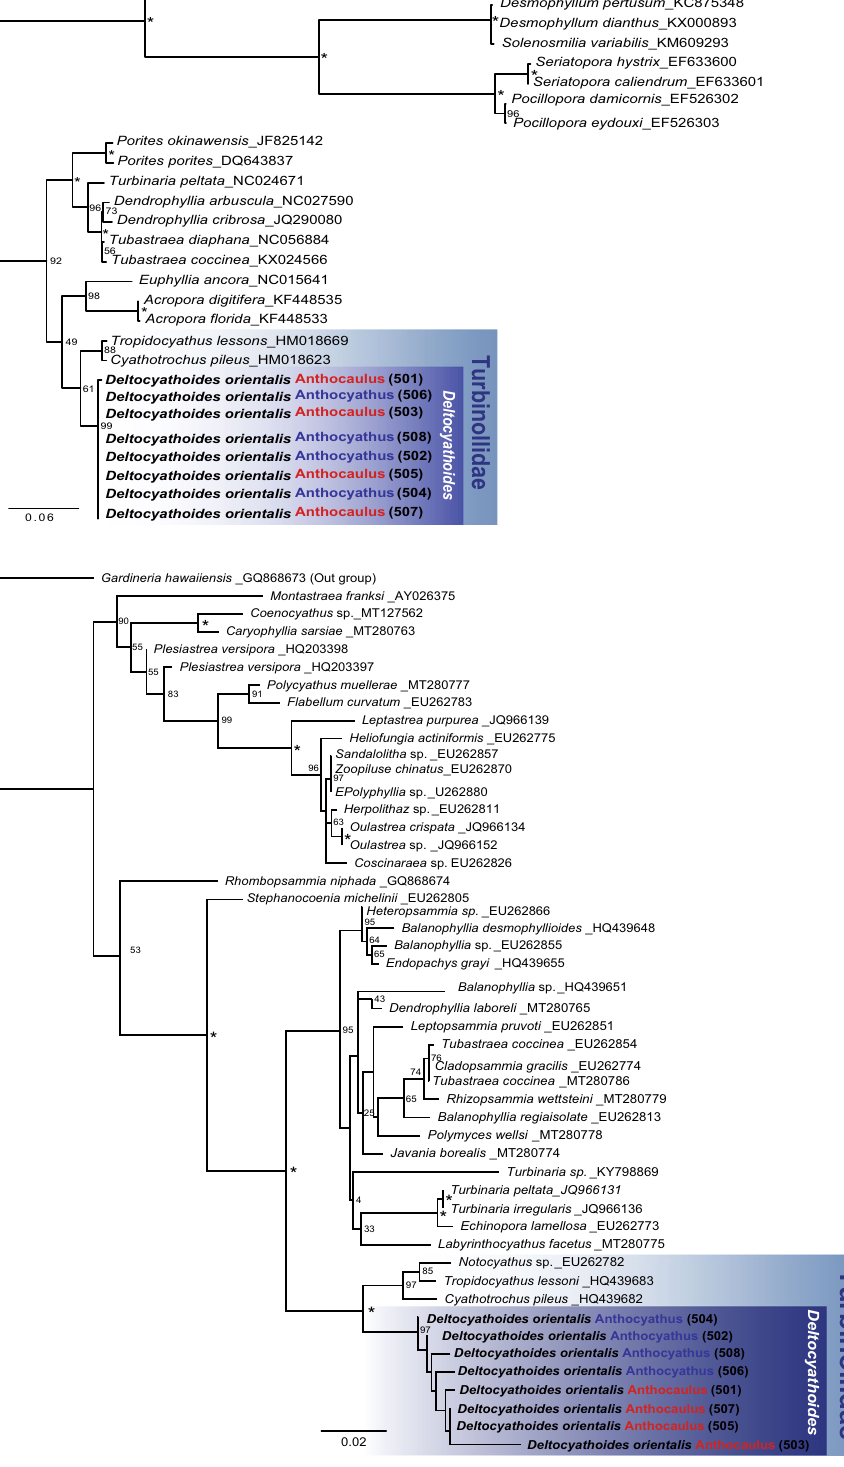
Figure 6. Phylogenetic analyses of the scleractinian corals based on two regions the mitochondrial COI ( A ) and the nuclear 28S ribosomal DNA ( B ) regions. All maximum likelihood trees were constructed using RA×ML with the GTR CAT model and 1000 bootstrap replicates. Numbers on the nodes indicate the bootstrap values. Asterisks indicate 100% bootstrap